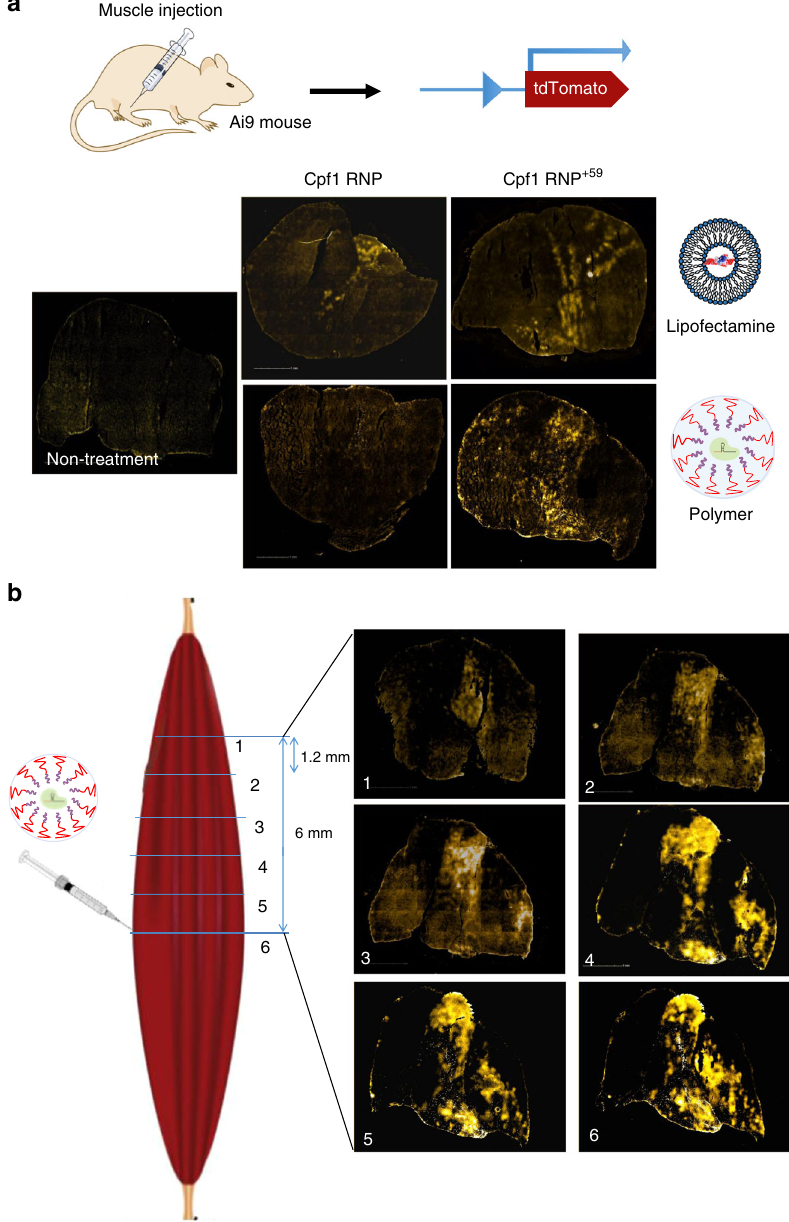
Fig. 7 Cpf1 RNP + 59 enhances the delivery ef fi ciency of Cpf1 RNP in vivo using polymer nanoparticle in Ai9 mice. a Fluorescence image of the entire gastrocnemius muscle cross-section that was injected with Cpf1 RNP. Cpf1 RNP ef fi ciently induces gene deletions and robust expression of tdTomato in Ai9 mice after delivery with PAsp derivative polymer or Lipofectamine. Width of each image is 6.5 mm. b Serial fl uorescence images of the entire gastrocnemius muscle injected with Cpf1 RNP, which was sectioned every 1.2 mm. Cpf1 RNP + 59 ef fi ciently induces gene deletions in Ai9 mice after delivery with PAsp derivative polymer and shows robust gene editing along the muscle fi ber. Width of each image is 6.5 Synthesis of gRNAs . crRNAs and sgRNAs were purchased from IDT or synthe- supplemented with 10% FBS (Seradigm #1500-500), and 100 U/ml penicillin and 100 μ g/ml streptomycin (Pen-Strep; Life Technologies Gibco, #15140-122) at 37 °C sized using in vitro transcription. The sequences of gRNA are given in the Sup- with 5% CO 2 . Monoclonal HEK-RT3-4 reporter cells, here referred to as “ GFP- plementary Data. The DNA template used for in vitro transcription was produced by overlapping PCR. Brie fl y, the forward primer and reverse primer (1 μ M) were HEK, ” were generated through low-copy transduction of HEK293T human mixed with Phusion DNA Polymerase (NEB) and PCR ampli fi cation was con- embryonic kidney cells with the amphotropic-pseudotyped retrovirus RT3GEPIR- ducted. The DNA template was puri fi ed with a PCR clean-up kit. The Megascript sh.Ren.713 72 , comprising an all-in-one Tet-On system enabling doxycycline- T7 RNA polymerase kit (Thermo Fisher) was used to make gRNAs. Polyacrylamide controlled EGFP expression. After puromycin (2.0 μ g/ml) selection of transduced gel extraction was conducted to make sure uniform sized gRNAs were produced. HEK239Ts, 36 clones were isolated and individually assessed for (i) growth The concentration of puri fi ed gRNA was determined with a Nanodrop 2000 characteristics, (ii) homogeneous morphology, (iii) sharp fl uorescence peaks of (Thermo Fisher Scienti fi c) and the fi nal gRNA products were stored at − 80°C. doxycycline- (1 μ g/ml) inducible EGFP expression (Guava EasyCyte, Millipore), (iv) relatively low fl uorescence intensity to favor clones with single-copy reporter integration, and (v) high transfectability. HEK-RT3-4 cells are derived from the HEK293T reporter cell lines . HEK293T cells (293FT; Thermo Fisher Scienti fi c), clone that performed best in these tests (Supplementary Fig. 7). BFP-HEK cells were generated by transfecting HEK cells with a BFP-containing lentivirus, and derived cell lines, were grown in DMEM (Corning Cellgro, #10-013-CV)